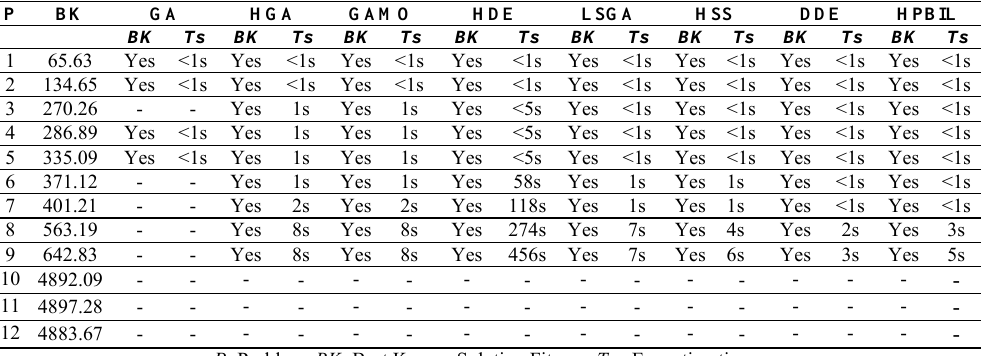
Table 3. Results – Evolutionary Algorithms.